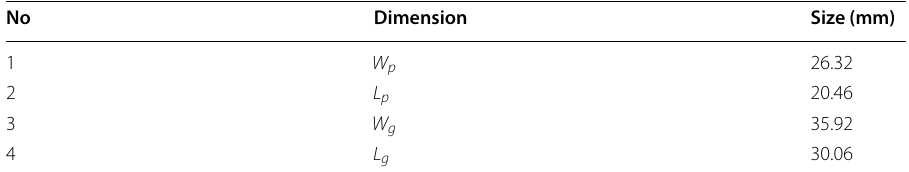
Table 1 Dimension of patch